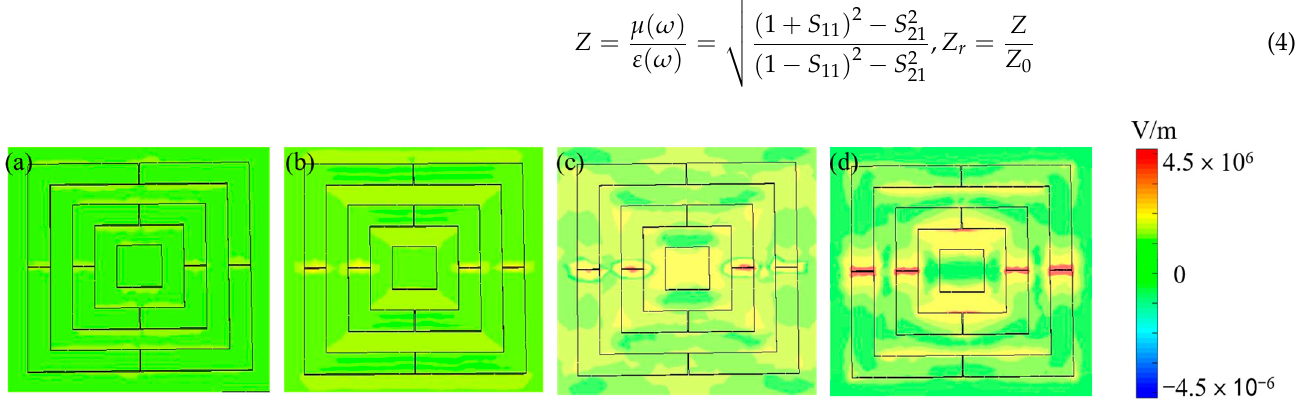
Figure 5. Electric field distribution at the center frequency of 5.17 THz when the conductivity of VO 2 is ( a ) 2 × 10 2 S/m, ( b ) 2 × 10 3 S/m, ( c ) 2 × 10 4 S/m, and ( d ) 2 × 10 5 S/m.